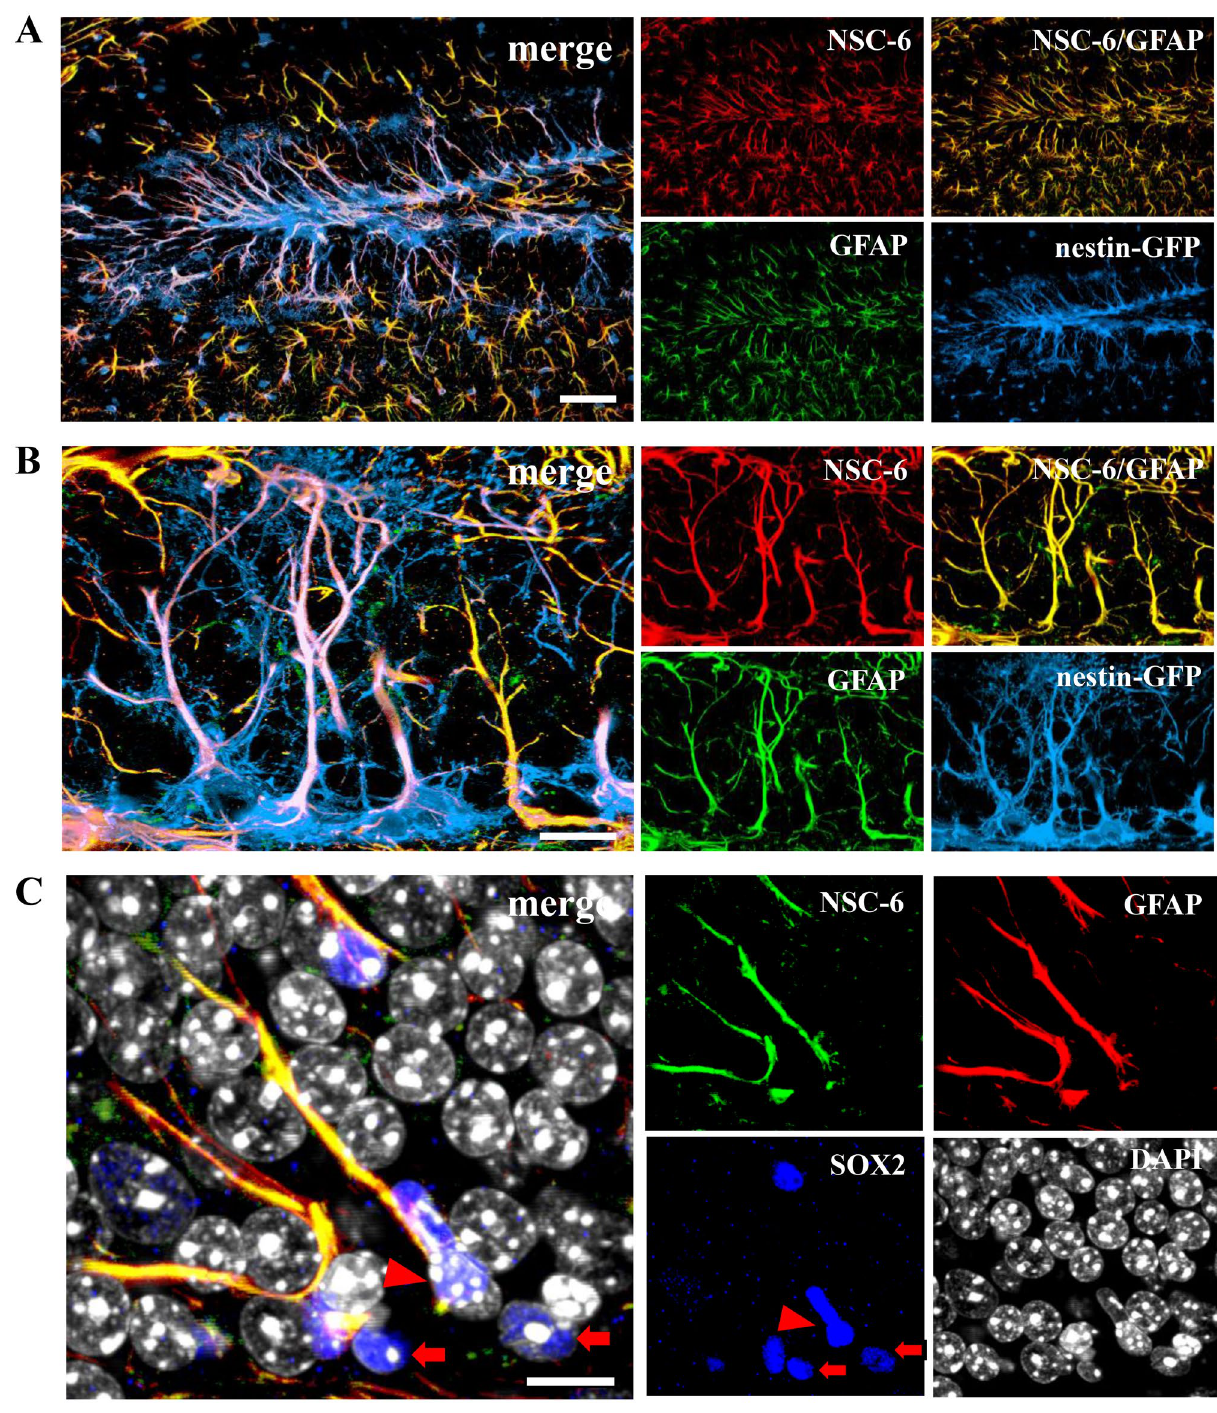
Figure 5. NSC-6 antibody immunolabels adult hippocampal NSCs but not ANPs. ( A ) NSC-6 immunolabeling co-localizes with GFAP in the hilus, the SGZ, the granular cell layer, and the molecular layer of the dentate gyrus. ( B ) NSC-6 immunolabeling co-localizes with GFAP and Nestin -GFP in the radial process of the NSCs located in the SGZ. ( C ) NSC-6 does not label Sox2+ GFAP− ANPs (arrows) adjacent to NSC-6+; GFAP+; Sox2+ NSCs (arrowhead). Scale bars are 25 µm in A, 5 µm in B, and 10 µm in ( C